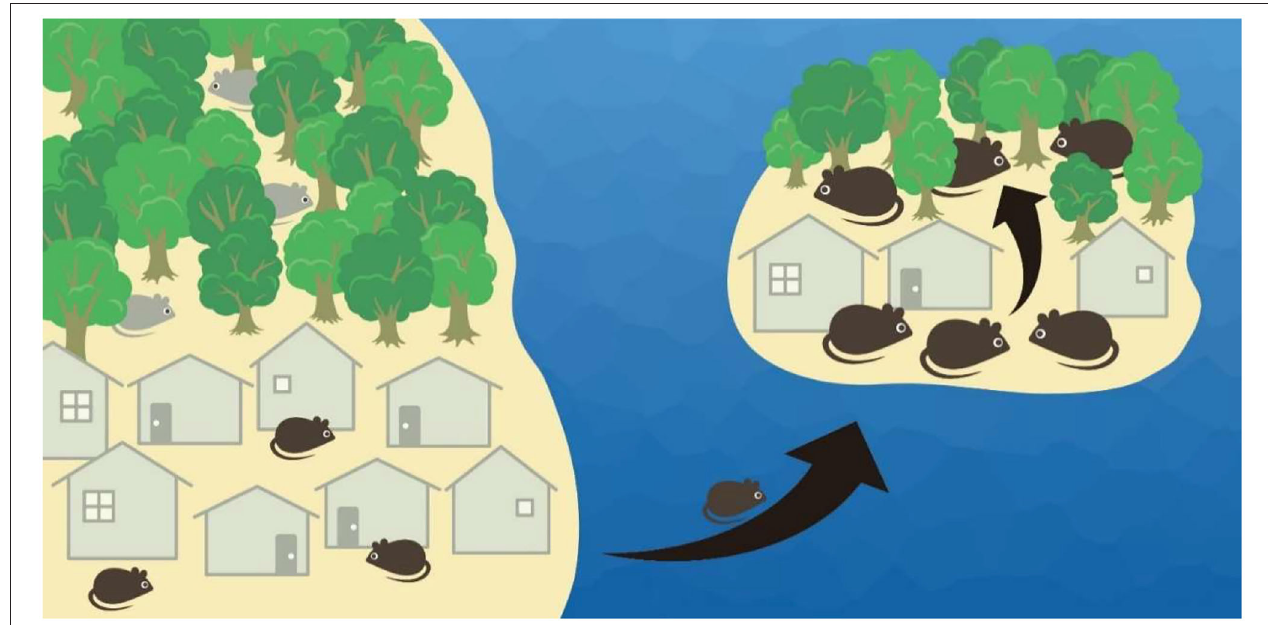
FIGURE 1 | When colonizing ocean islands from the mainland, rodents generally become larger and reach higher population densities. Also, release from competitors on islands allows rodents to expand habitat use; e.g., commensal rodent species (black color) is confined to human settlements on the mainland when competitive species (gray color) occupies the forests, but is allowed to enter the forests when the competitor is absent on the